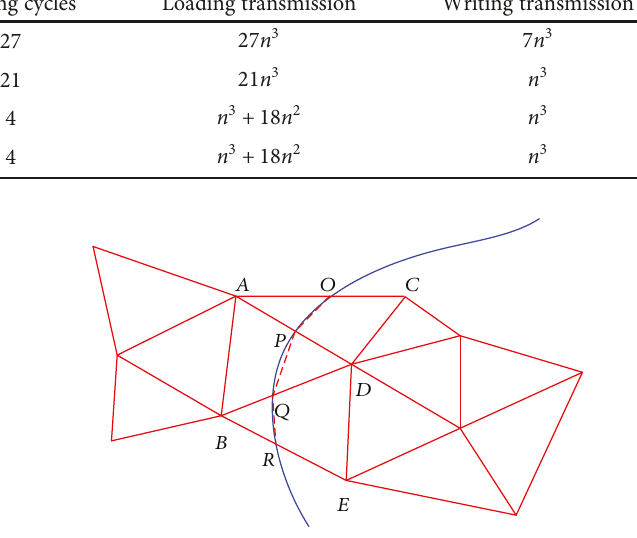
Figure 7: SDF-based Boolean